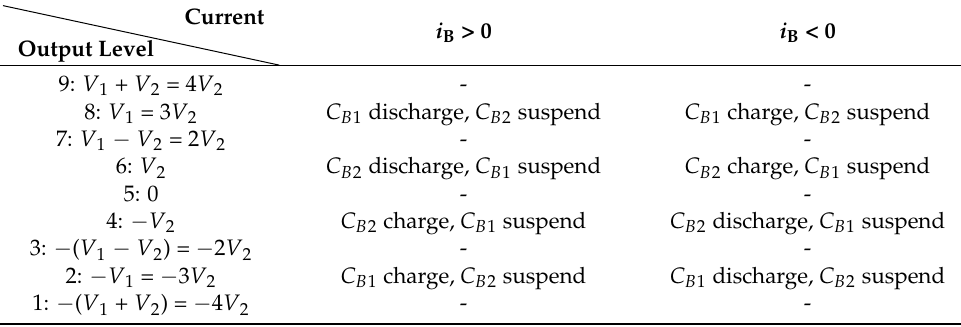
Table 3. Determination of charge and discharge status of C B 1 and C B 2